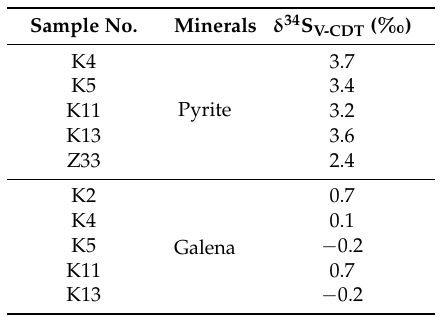
Table 9. Sulfur isotope compositions of sulfides from the Xiajinbao gold deposit.